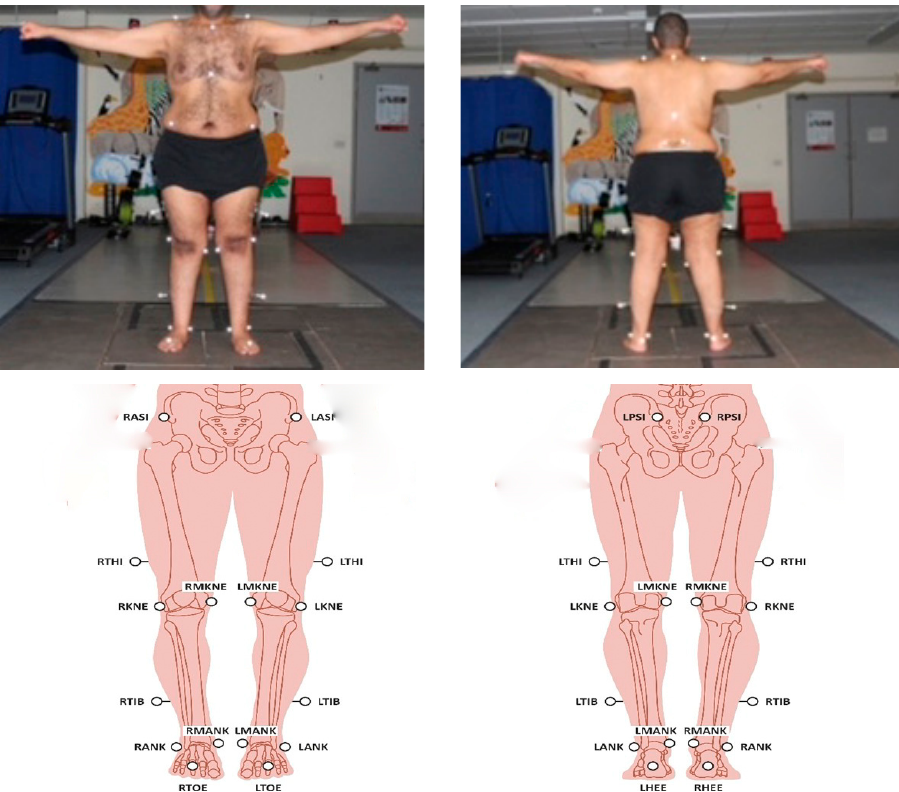
Figure 1. Marker placement ( upper ) according to Vicon ® Plug-in-Gait Model ( lower ). Note: Subject with markers: front view ( left ) and back view ( right ); the shoulder and trunk markers used for balance analysis.